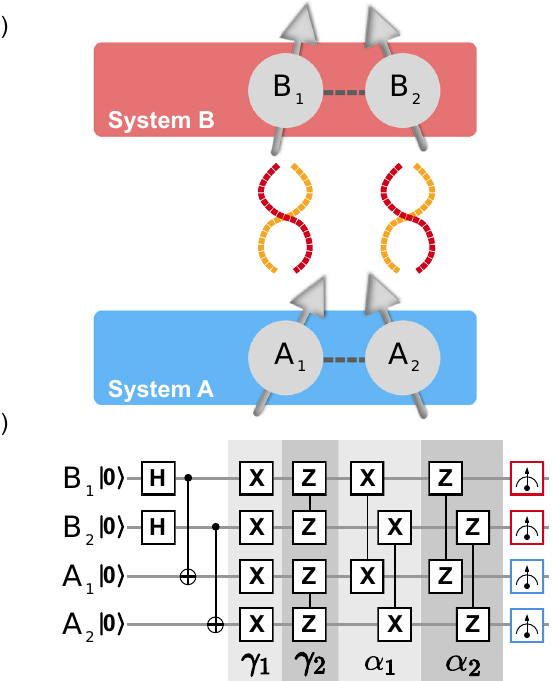
Fig. 1 Principle and generation of Thermo fi eld Double state. a Two identical systems A and B are variationally prepared in an ideally pure, entangled joint state such that tracing out one system yields the Gibbs state on the other. b Corresponding qubits in the two systems are fi rst pairwise entangled to produce the β = 0 TFD state. Next, intra- and inter-system Hamiltonians are applied with optimized variational angles α ; γ ð Þ to approximate the TFD state corresponding to the desired